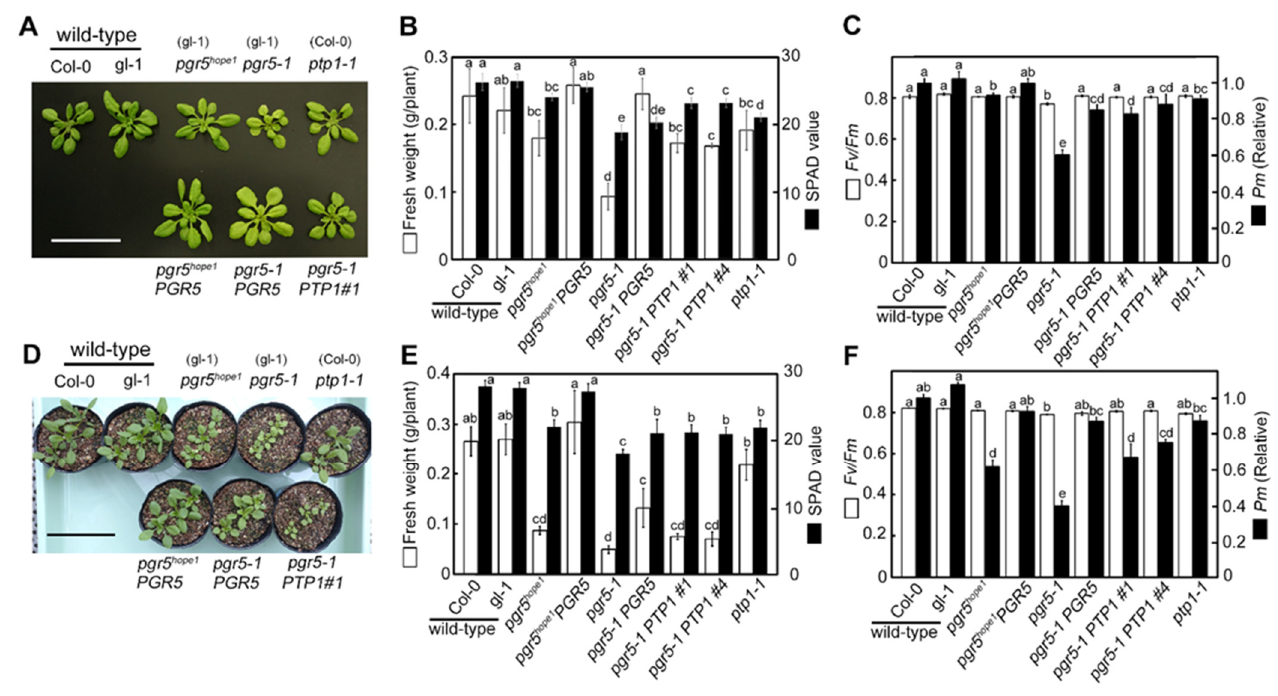
Figure 2. The phenotypic recovery in complementation lines. ( A – C ) and ( D – F ) were the data of plants grown under constant (250 µ mol-photons m − 2 s − 1 ) and natural light conditions, respectively. ( A , D ) are pictures of representative plants grown for 22 days and 20 days, respectively. The parentheses indicate the background genotypes of each mutant. The scale bars in ( A , D ) are 5 and 8 cm, respectively. ( B , E ) show fresh weight (white bars) and SPAD values (black bars). Data are means ± sd. (( B ), n = 6; ( E ), n = 4–5) ( C , F ) show the maximum quantum yield in PSII ( Fv/Fm ; white bars) and the maximum amount of photo-oxidizable PSI ( Pm ; black bars). Data are means ± sd. (C, n = 5–6; F, n = 4–5) Pm is a relative value with the value wild-type Col-0 being 1. In ( B , C , E , F ), the different alphabets indicate significant differences analyzed by Tukey’s HSD test. ( p < 0.05).